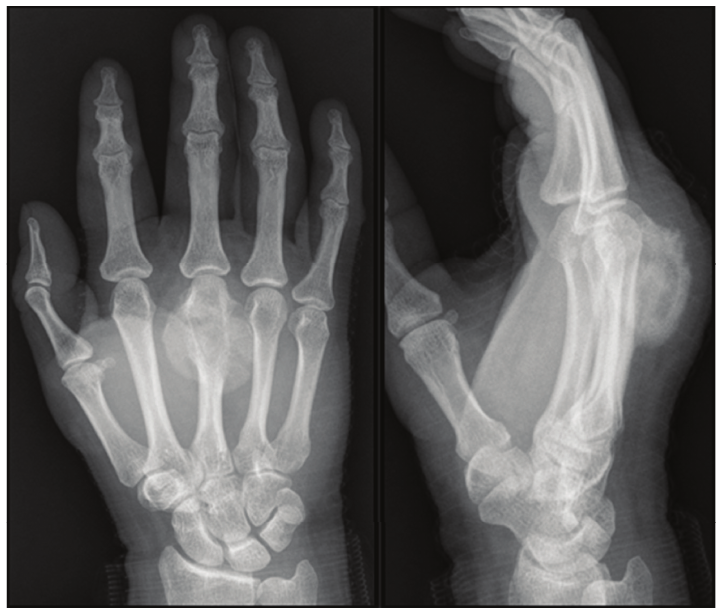
Figure 4: Radiograph taken preoperatively showing rapid growth of the dorsal mass.